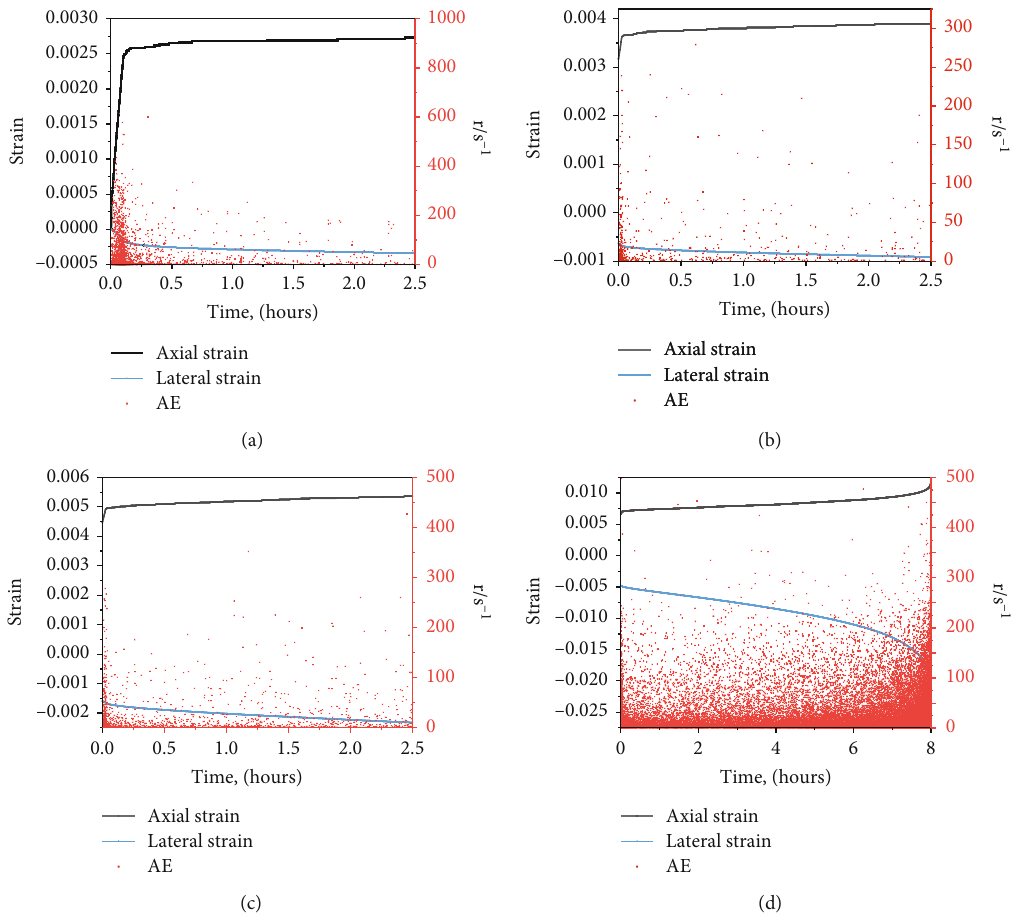
Figure 13: The relationship between the time, strain, and AE signal of the mudstone interlayer at each loading